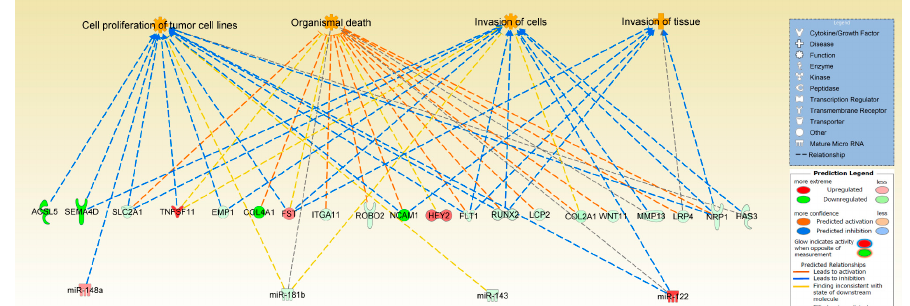
Figure 3. Significant pathways and networks affected in cartilage ageing . IPA was used to pair differentially expressed mRNA and miRNA data from ageing equine cartilage and chondrocytes. Figure is a graphical representation between molecules identified in our data in their respective networks. Red nodes; upregulated gene expression in old group; green nodes; downregulated gene expression in old group. Intensity of colour is related to higher fold-change. The key to the main features in the networks is